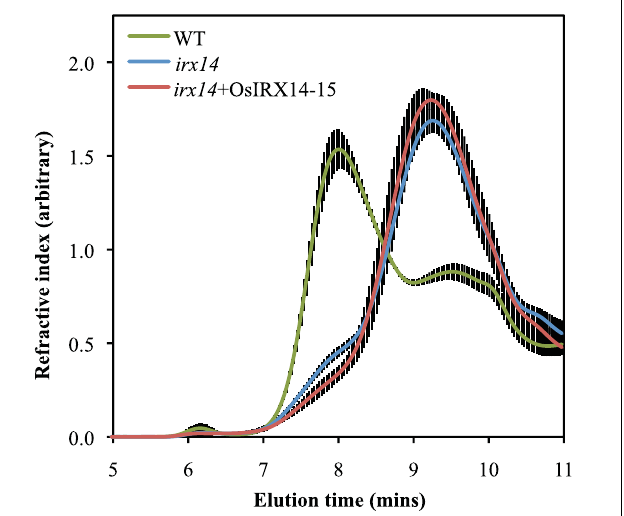
line has a xylan length comparable to wild type;The OsIRX14 complemented line appears to have a xylan chain length like the irx14 mutant. Equal amounts of carbohydrate were loaded onto the column. Error bars represent SD with at least three biological